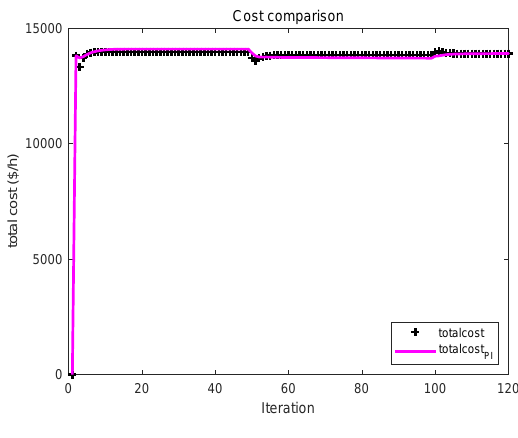
Figure 9. Comparison of total cost of two